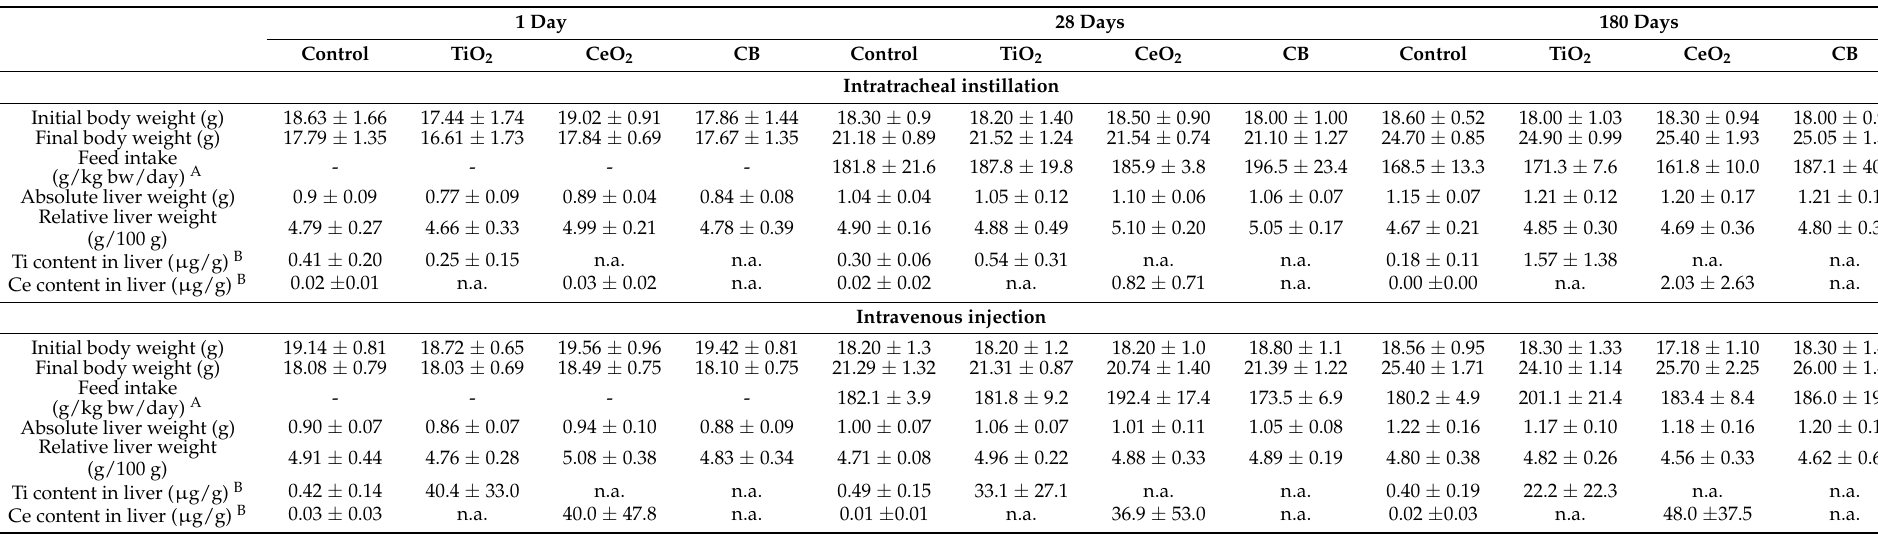
Table 2. Initial and final body weights, feed intake, absolute and relative liver weights and titanium or cerium content of mice